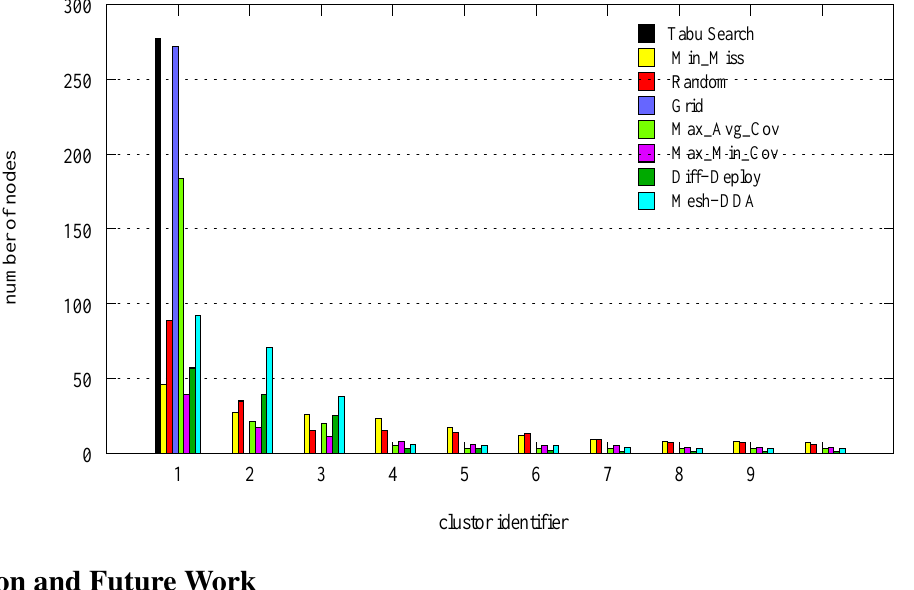
Figure 9. Connected components of wireless network communication